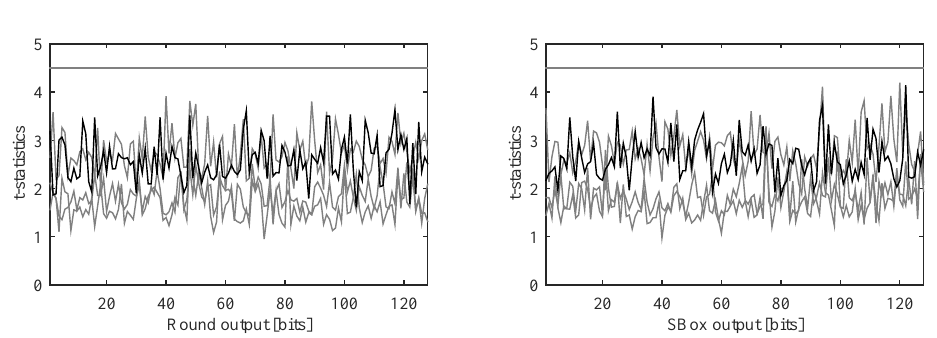
Figure 7: Univariate results of specific t-tests using 2 billion traces targeting the fifth round of AES-128 (absolute t-statistics of round output and S-box output). First-order results are drawn in black, second-order up to fourth-order results are drawn in